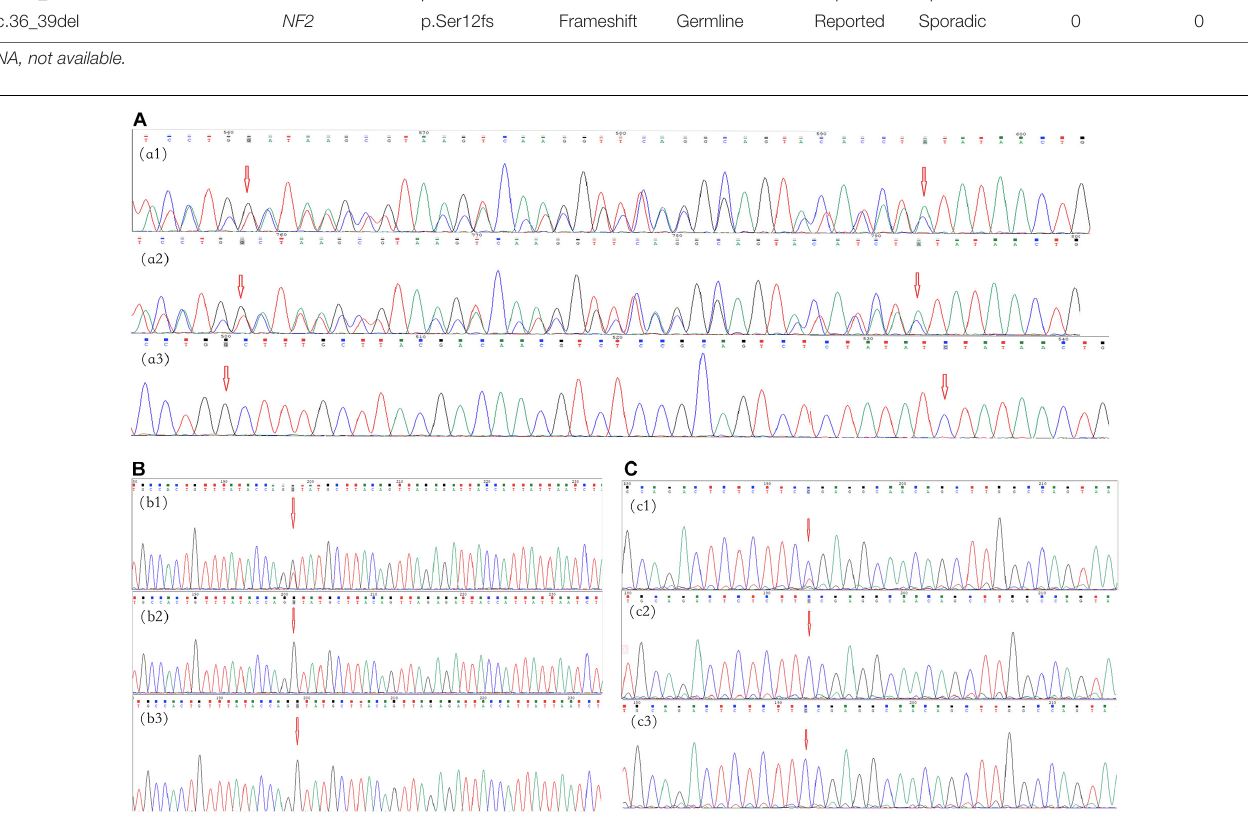
FIGURE 2 | Mutational analysis of the neurofibromatosis (NF) patients in families 1–3. The red arrows indicate the mutation sites. (A) Family 1: the c.5072_5073insTATAACTGTAACTCCTGGGTCAGGGAGTACACCAA:p.Tyr1692Ilefs frameshift variant in NF1 in exon 37 in proband III-1 ( a1 ) and her father ( a2 ) ; there was no mutation in her mother ( a3 ) . (B) Family 2: the c.4110 + 1G > T splicing variant in NF1 at the first base downstream of the 3 (cid:48) -end of exon 30 in proband II-1 (b1) ; there were no mutations in her father and mother ( b2,b3 , respectively). (C) Family 3: the c.3826C > T:p.Arg1276Ter missense variant in NF1 in exon 28